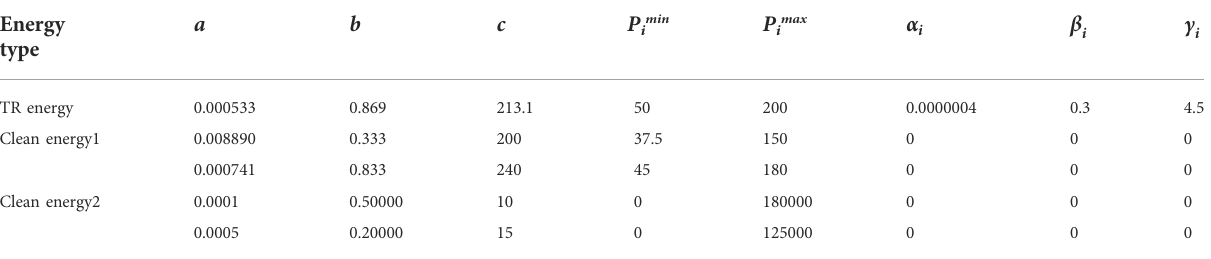
TABLE 1 Parameters of power generating equipment.